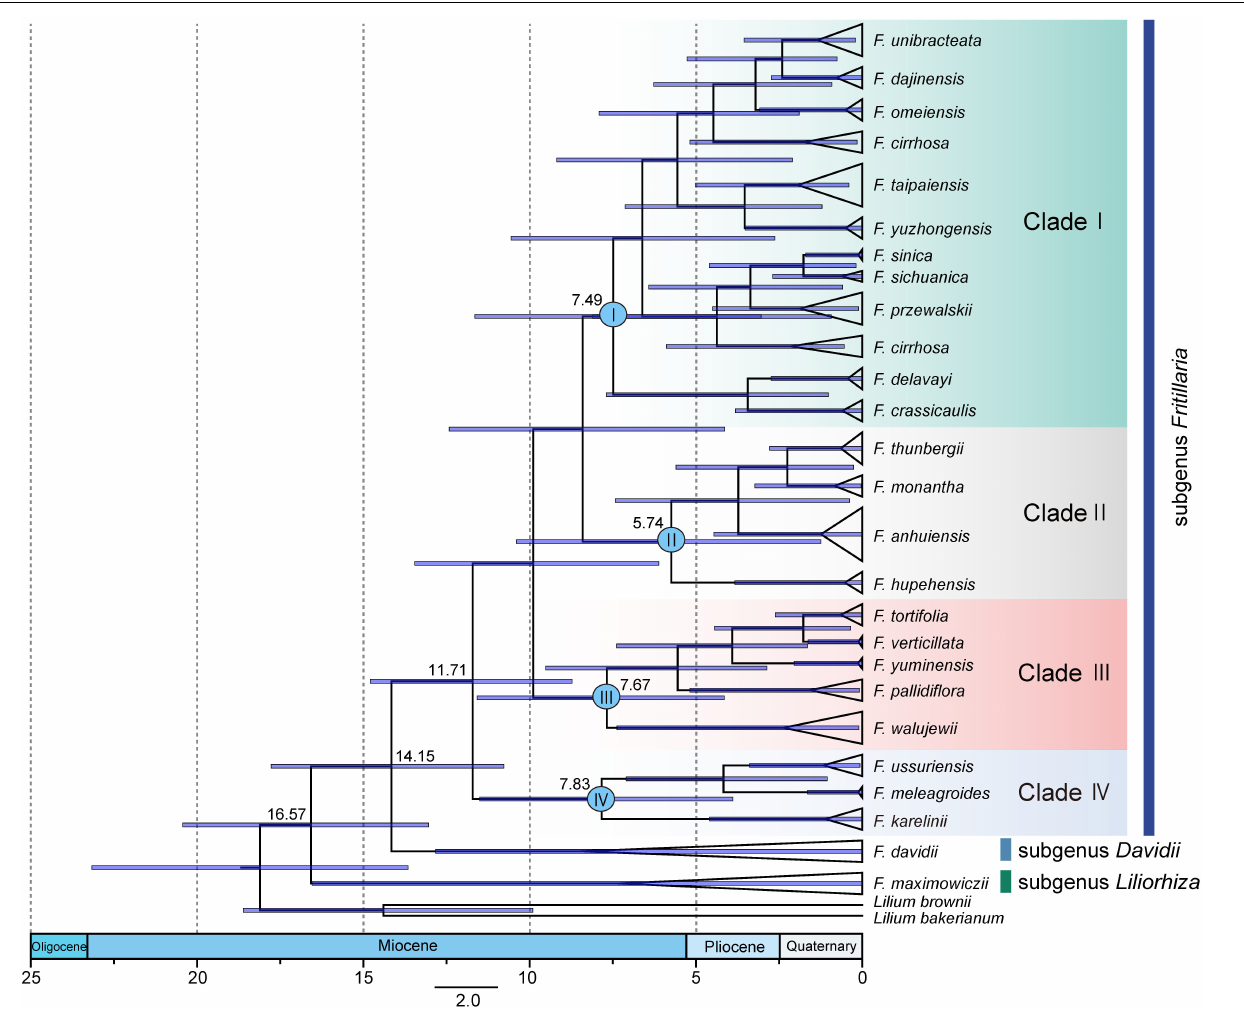
FIGURE 5 | Maximum clade credibility (MCC) tree of the 25 Fritillaria species from BEAST analysis under the Yule tree prior and lognormal uncorrelated relaxed clock models on the basis of complete plastomes. Blue bars represent 95% credibility intervals for each node with posterior probability above